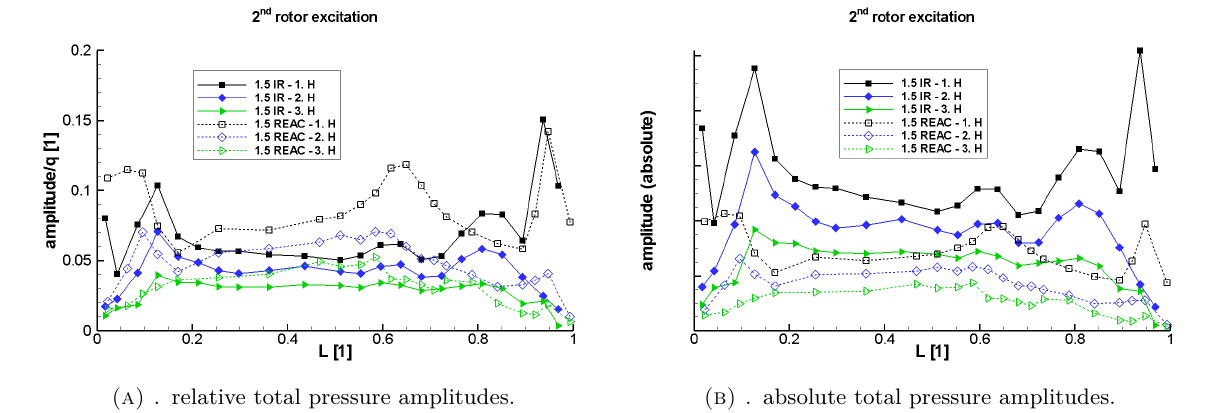
Figure 3. The second rotor excitation - REAC and IR stage.